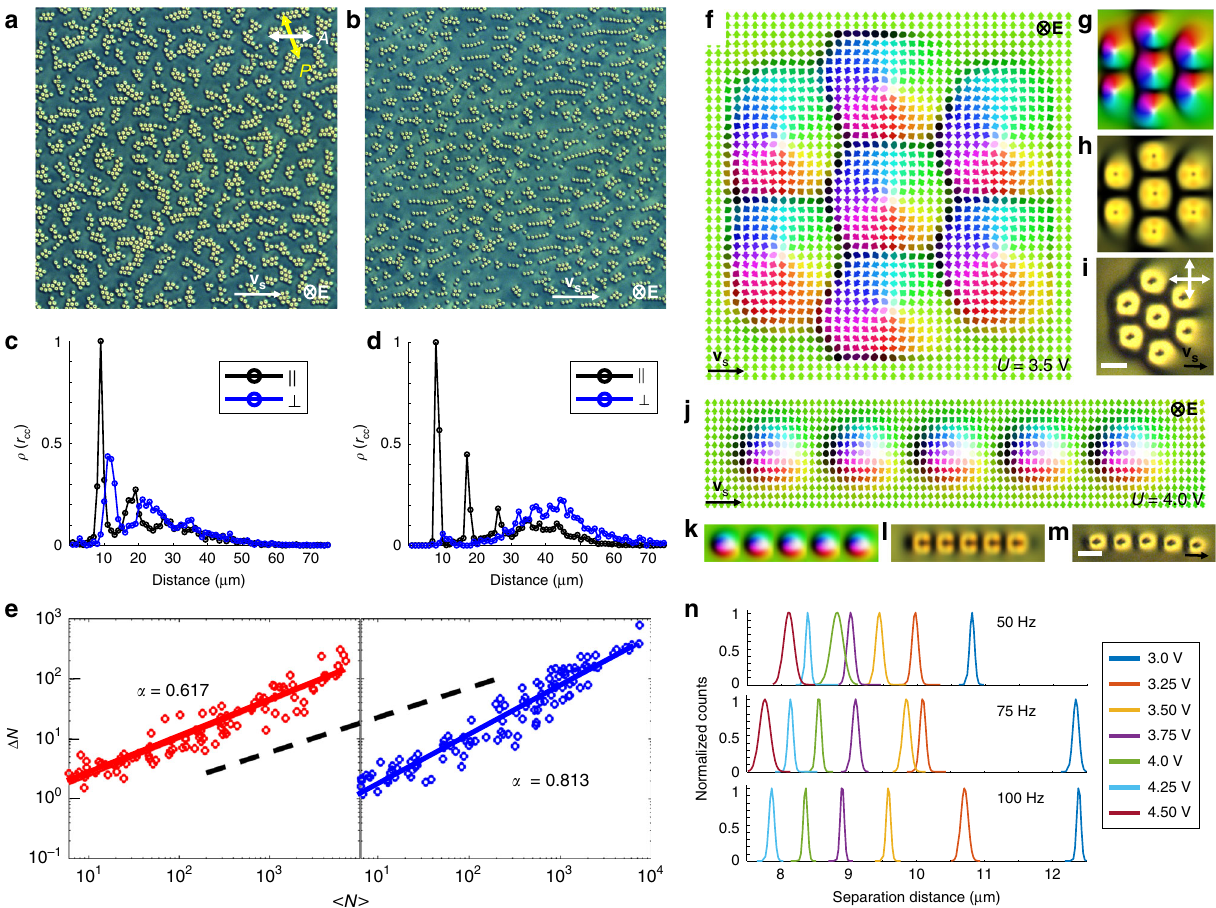
Fig. 5 Schools of skyrmions with internal clusters and chains. a , b Polarizing micrographs show schooling of skyrmions with clusters at U = 3.5 V ( a ) and chains at U = 4.0 V ( b ), where f = 50 Hz. The scale bar in a is 100 µ m. c , d Normalized skyrmion count distributions ρ ⊥ ( r cc ) and ρ || ( r cc ) for directions perpendicular and parallel to the motion directions for clusters ( c ) and chains ( d ) shown in a , b , respectively. e Log – log plots of Δ N versus < N > for clusters (red) and chains (blue); linear fi ts with slope α values and a black dashed line with α = 0.5 (for reference) are displayed. f , g Computer-simulated moving cluster of seven quasi-hexagonally assembled skyrmions at U = 3.5 V displayed using arrows colored according to the color scheme in Fig. 1g. ( f ) and corresponding smoothly colored representation of n ( r ) ( g ). h Simulated and i experimental polarizing optical micrographs of a similar moving cluster. j , k Simulated moving linear chain of fi ve skyrmions at U = 4.0 V ( j ) with corresponding smoothly colored n ( r ) representation ( k ). l Simulated and m experimental polarizing micrographs of the moving chain. Scale bars in i , m are 10 µ m. Upon turning voltage off and on again while minimizing n ( r ), the clusters in f , j shift laterally within the computational volume by about ~0.5 p . n Experimental normalized distributions for inter-skyrmion distance in chains during motion versus U for f = 50, 75, and 100 Hz. Polarizer orientations (double arrows), v s and E , are labeled throughout. The LC is the nematic ZLI-2806 doped with the chiral additive